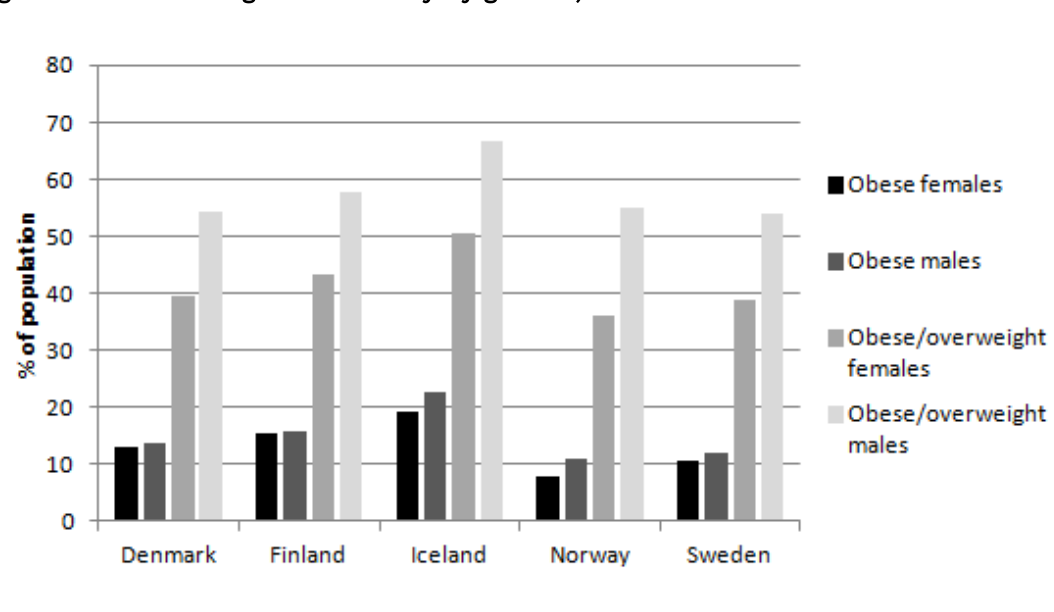
Figure 7: Overweight and obesity by gender,